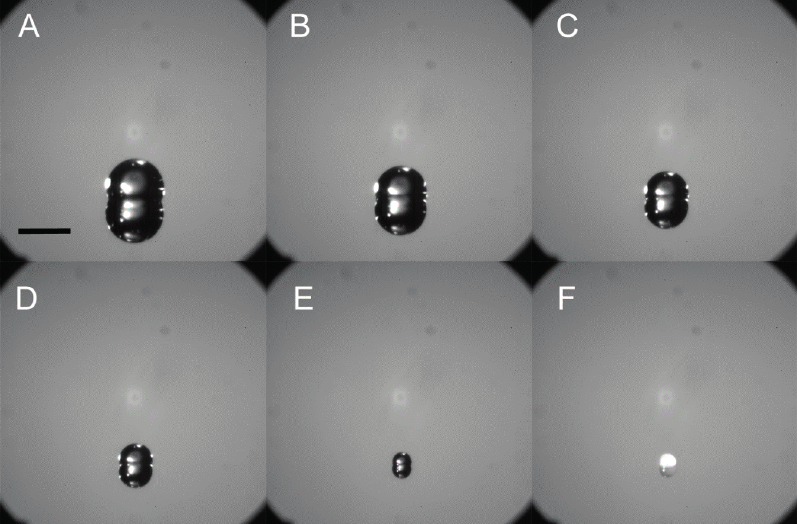
Figure 2. A series of time lapse optical microscope images ( A – F ) of several thousand microdrops of an ammonium nitrate solution inkjet-printed onto the silane coated silicon. The collection of multiple microdrops forms a larger ensemble drop that maintains a spherical acquired 18.5 s apart. The scale bar is 4